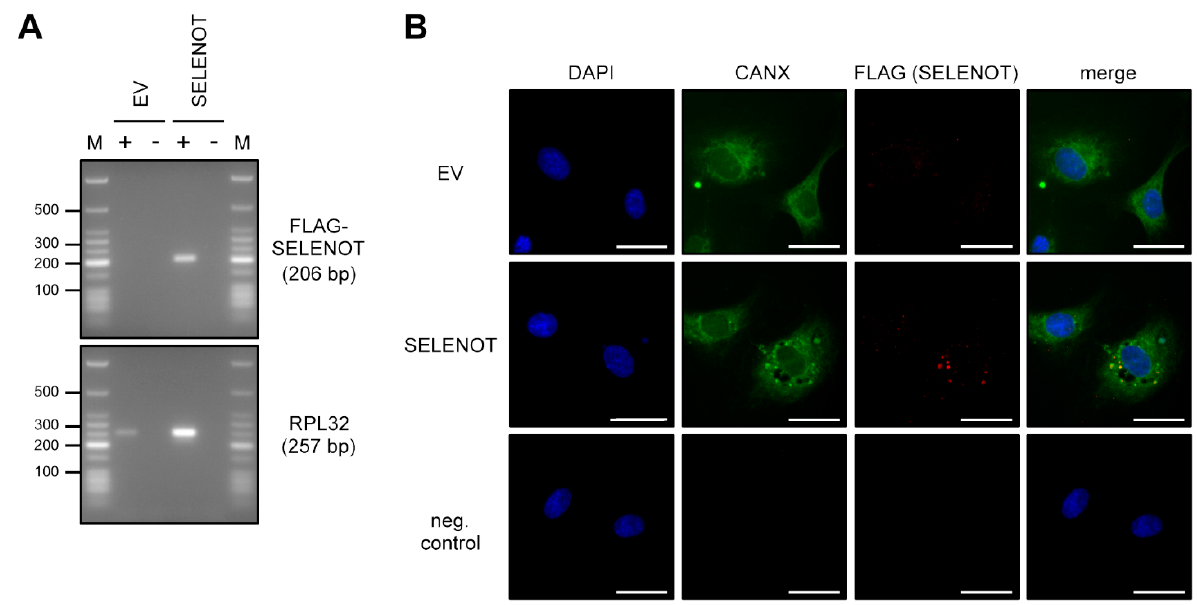
Figure 3. Overexpressed SELENOT is localized in the ER. ( A , B ) EC were transfected with the FLAG-SELENOT expression vector (SELENOT) or an empty vector (EV). Expression and localization of exogenously expressed SELENOT was verified on the RNA ( A ) and protein ( B ) level. ( A ) Expression of SELENOT was analyzed by reverse transcription polymerase chain reaction (RT-PCR). Therefore, RNA was isolated from the transfected cells and cDNA was synthesized in the presence (+) or absence ( − ) of reverse transcriptase. Amplification was performed with primers specifically detecting the FLAG-SELENOT fusion transcript, the housekeeping gene RPL32 served as control. Amplification products were resolved by agarose gel electrophoresis, the expected fragment sizes are specified, numbers on the left indicate selected DNA size markers (M). ( B ) Localization of FLAG-SELENOT was examined by immunostaining and fluorescence microscopy. Cells were stained with an antibody directed against Calnexin (CANX), a marker for the ER (green) and an anti-FLAG antibody (red). Nuclei were counterstained with DAPI (blue); merge is the overlay of all channels (scale bar = 30 µ